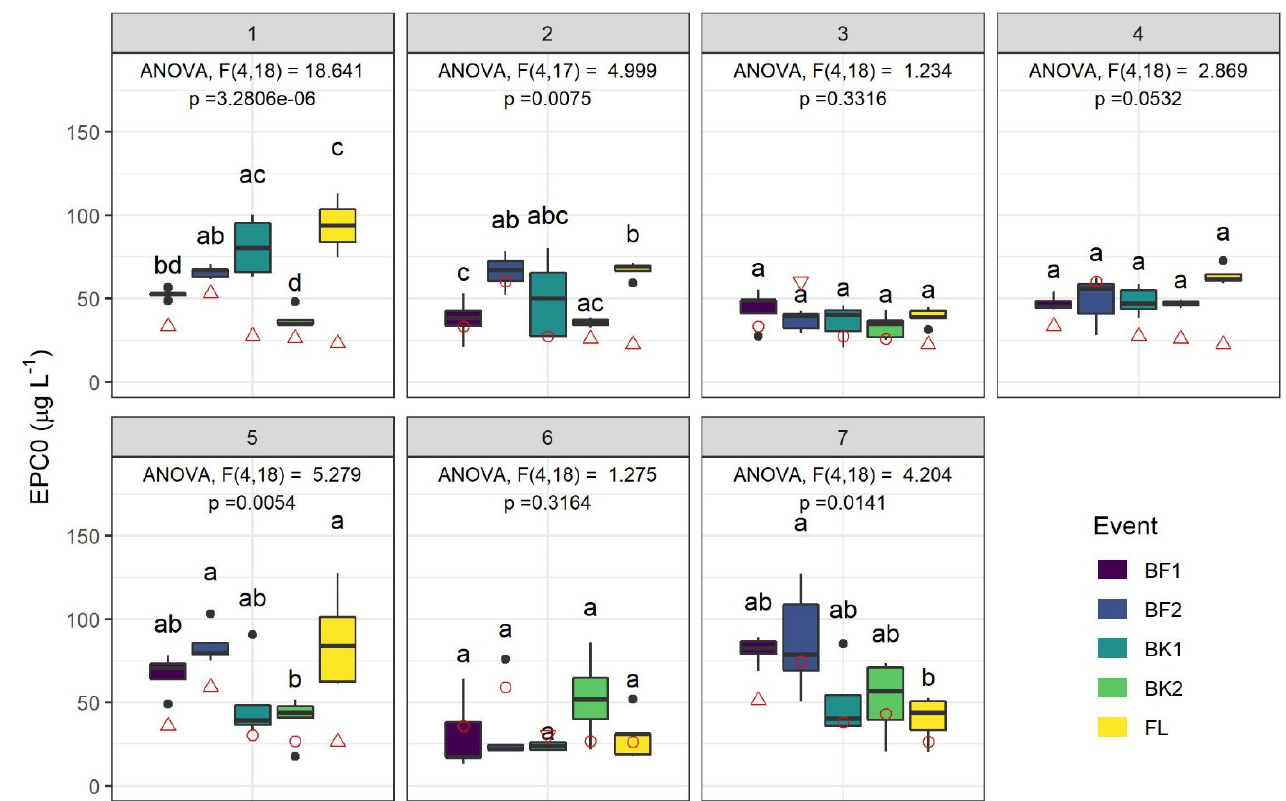
Figure 5. Boxplots represent the variability of EPC 0 across sampling sites and hydrological events (n = 5). The seven panels correspond to the seven sampling sites. The letters above the boxplot represent the clusters identified in the post-hoc test. Red symbols represent the SRP values measured in the water column during the field sampling. The shape of the symbol was obtained from a one-way t -test and showed when sediments are acting as a source of SRP (upwards triangle), as a sink (downwards triangle), or are in equilibrium with the water column (circle). Note: BF = baseflow, BK = bankfull, FL = flood. Refer to Table 1 and Figure 2 for the description of the events.